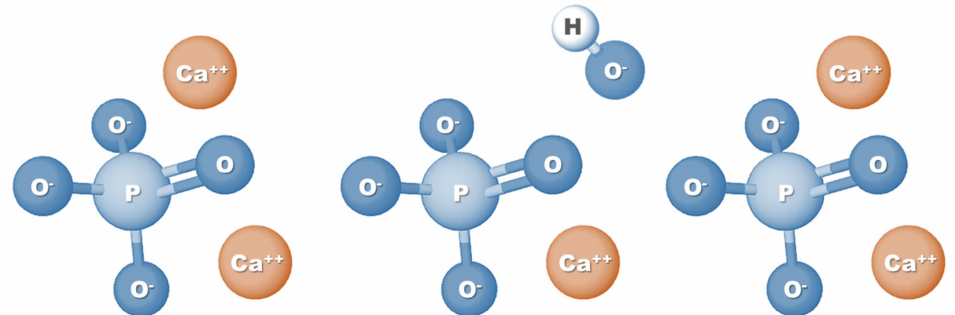
Figure 1. Chemical formula structure of